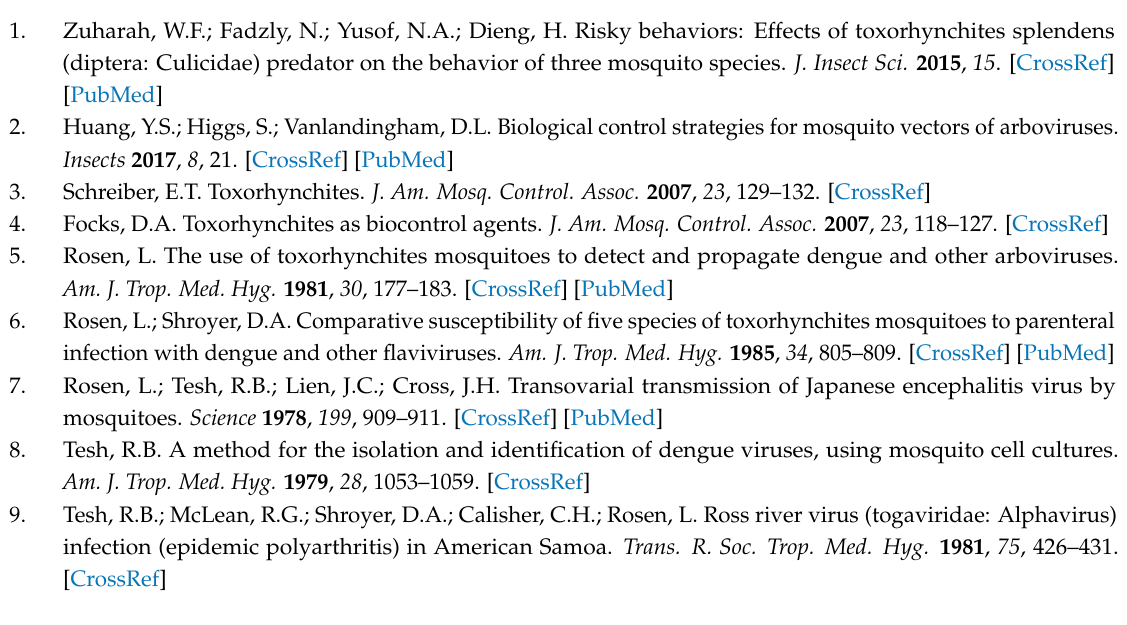
results, Table S3: Overview of assembled contigs showing similarity to viruses or